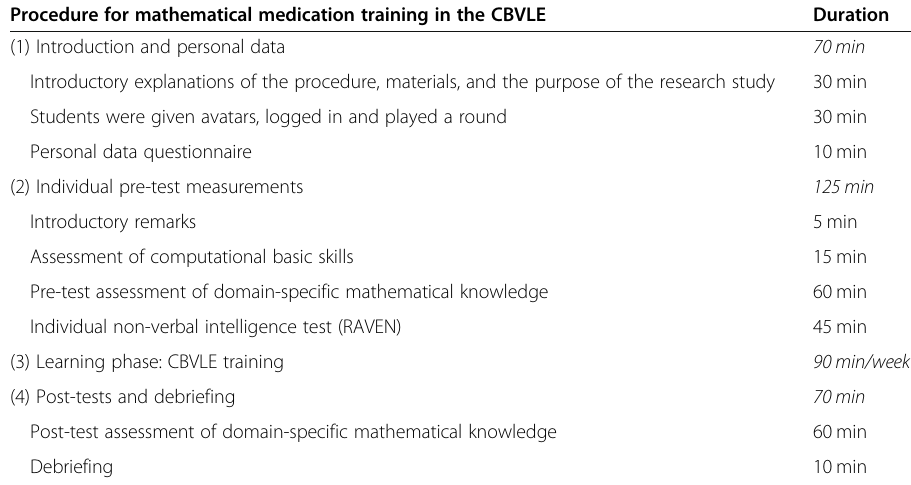
Table 2 Overview of the procedure for the CBVLE study Procedure for mathematical medication training in the